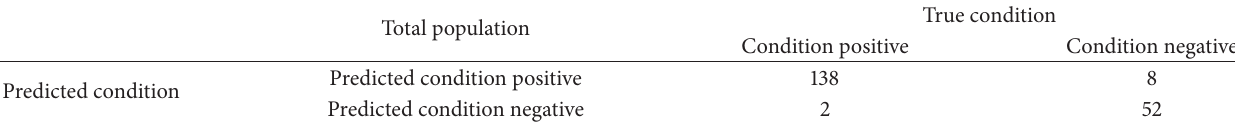
Table 1: Confusion matrix based on SVR model (200 instances of test data set).